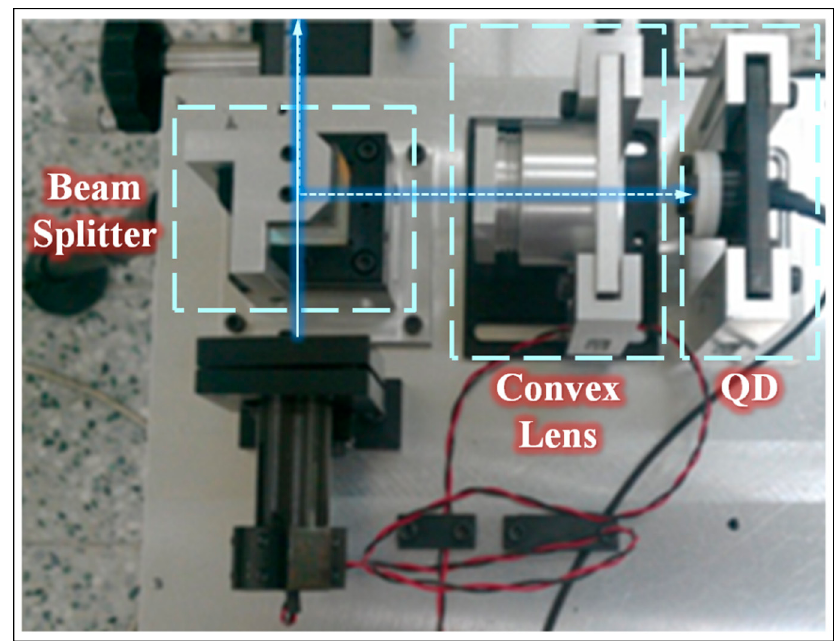
Figure 3. The in-lab-developed module for altitude angle calibration.